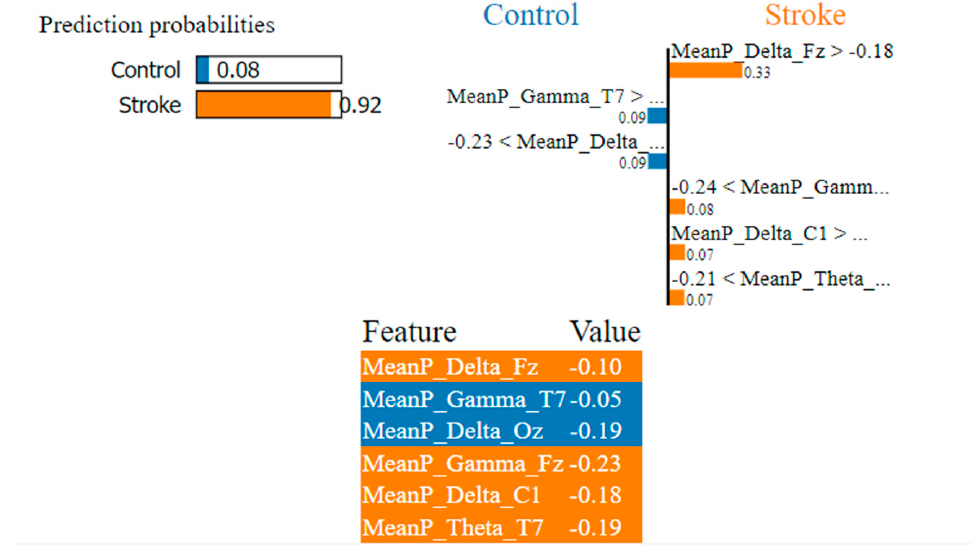
Figure 8. Visualization of the local contribution of EEG features through the LIME model in classifying a single test instance (predicted class = Stroke) using the LightGBM model. The orange-marked cells represent the features that contributed most to classifying the Stroke class.